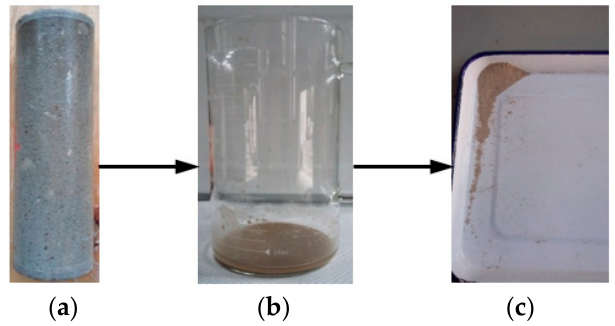
Figure 3. Photos of the exposed sample in group WB (water-immersion environment); ( a ) sample, ( b ) precipitate, and ( c ) oven dry. ( b ) precipitate, and ( c ) oven